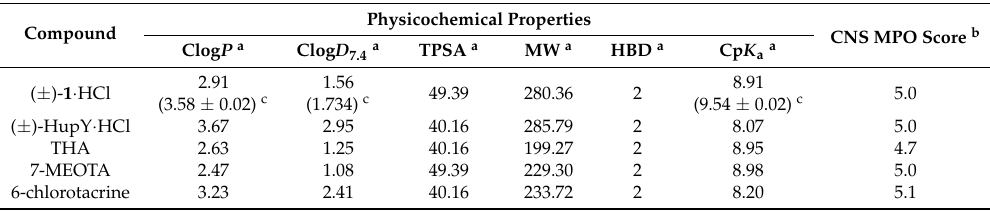
Table 3. Psychicochemical properties calculated by MarvinSketch 15.1.19.0 (Budapest, Hungary) and CNS MPO scores for ( ± )- 1 · HCl and standards under the survey.